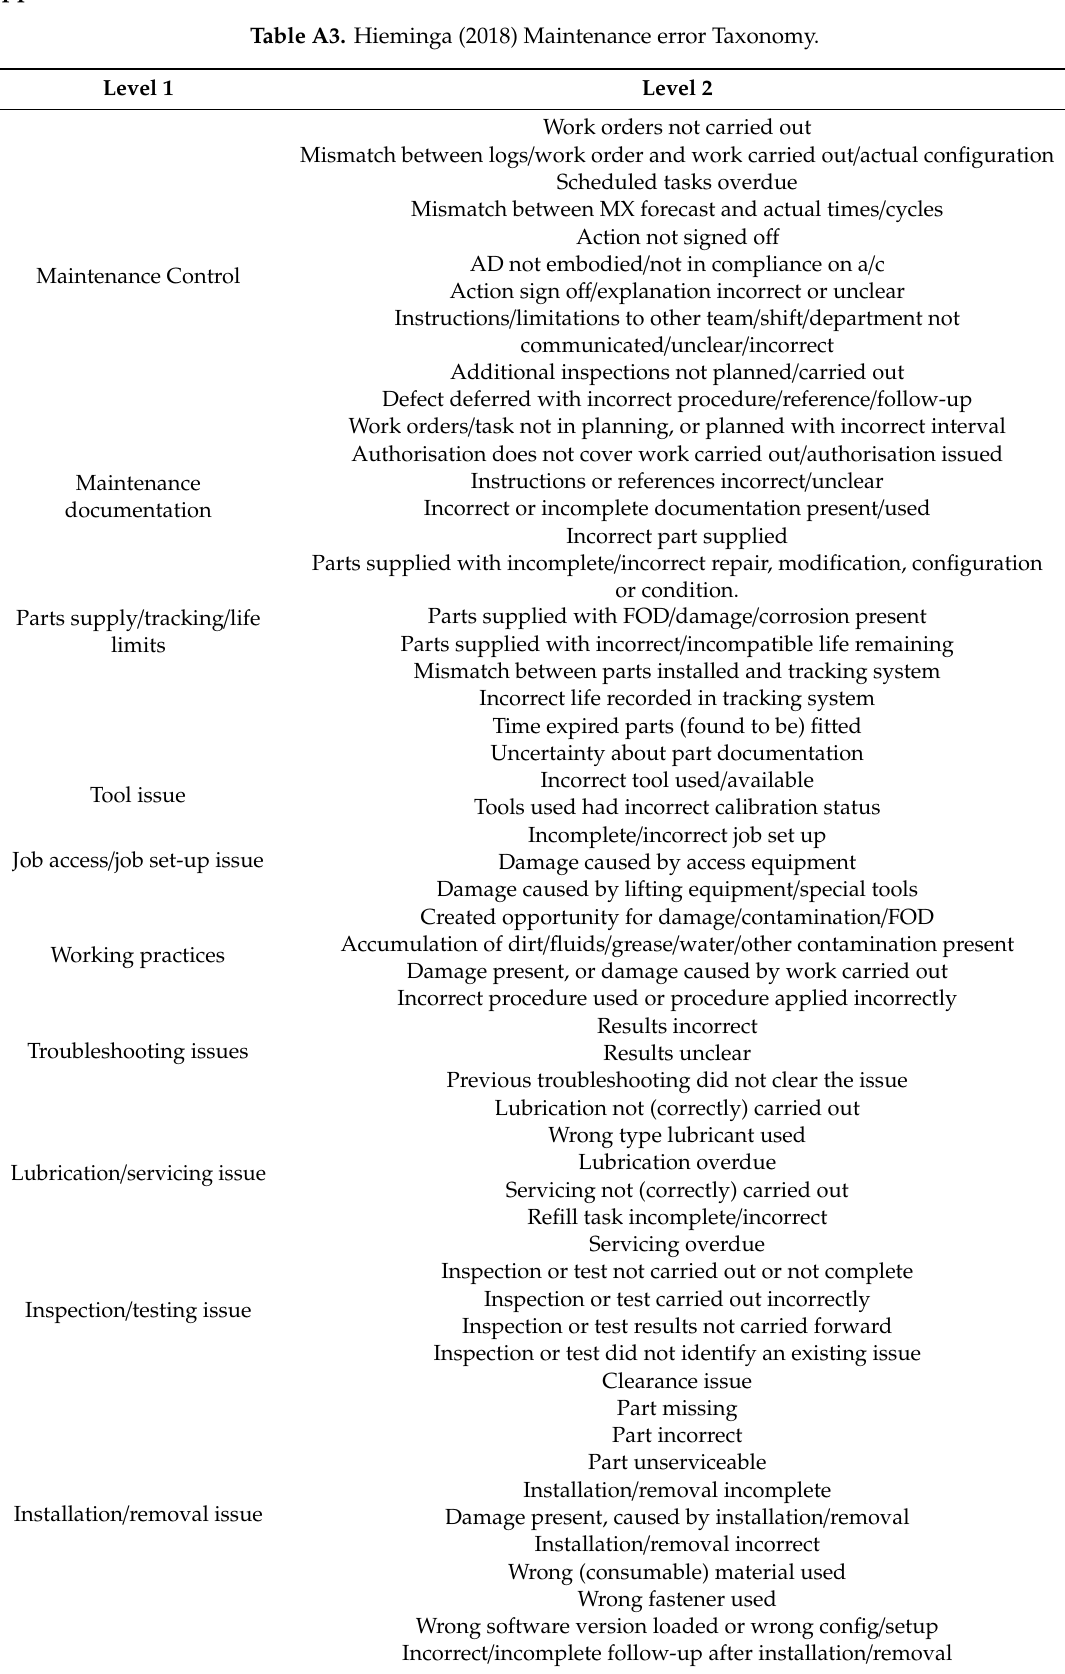
Table A3. Hieminga (2018) Maintenance error